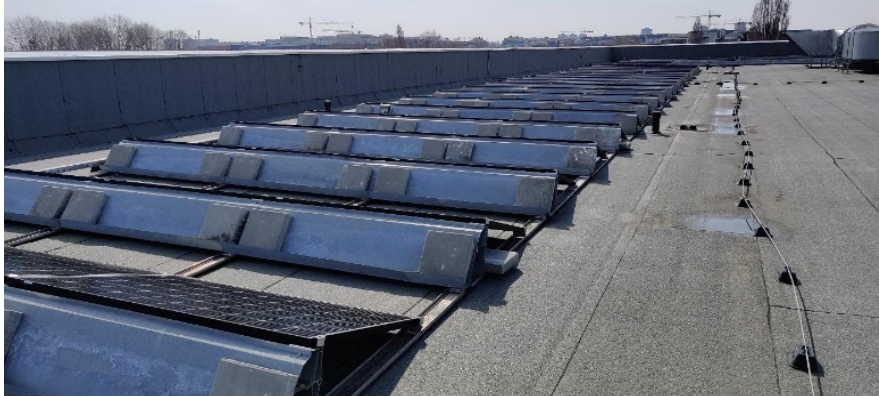
Figure 9. Photo of aluminum substructure on the roof.